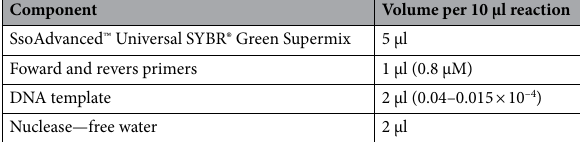
Table 7. Composition of PCR mix.